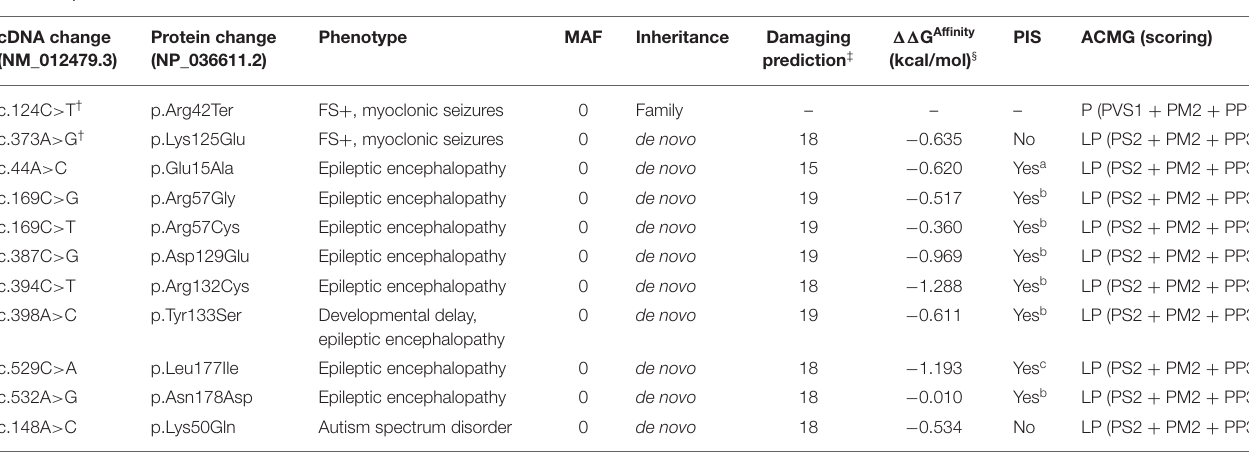
TABLE 2 | Genetic feature of YWHAG